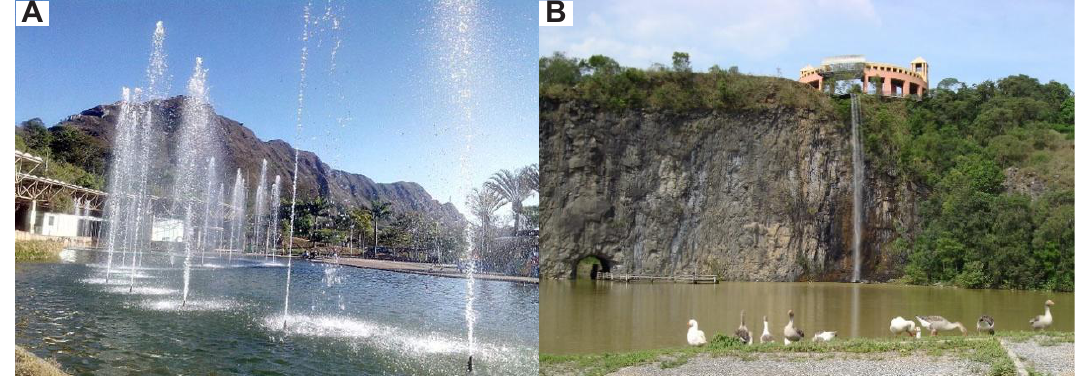
FIGURE 1 . Examples of Class 1 Geo-mining Heritage. A - Municipal Park of Mangabeiras, in Belo Horizonte, requalifying an old iron ore mining at the foot of Serra do Curral (photo Eliezer S. Costa). B - Tanguá quarry, in Curitiba, an old quarry of gneiss and diabase re-qualified for tourist use, preserving the exposure of rocks (photo by Leonardo Stábile)